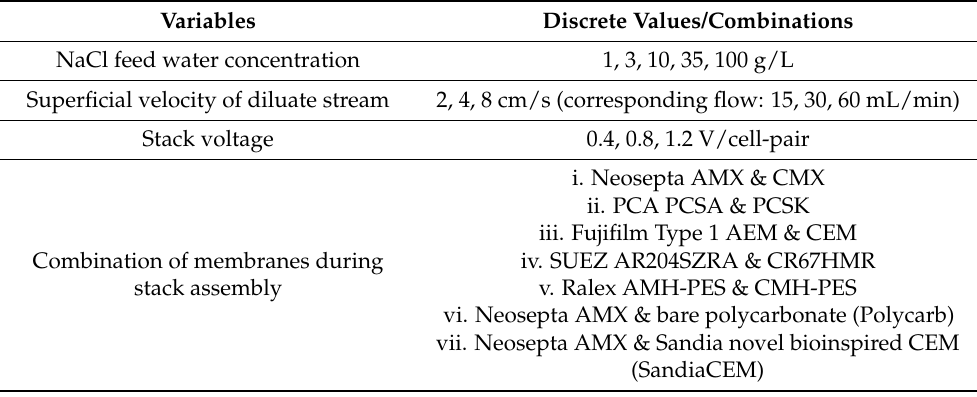
Table 1. Experimental variables, value ranges, and